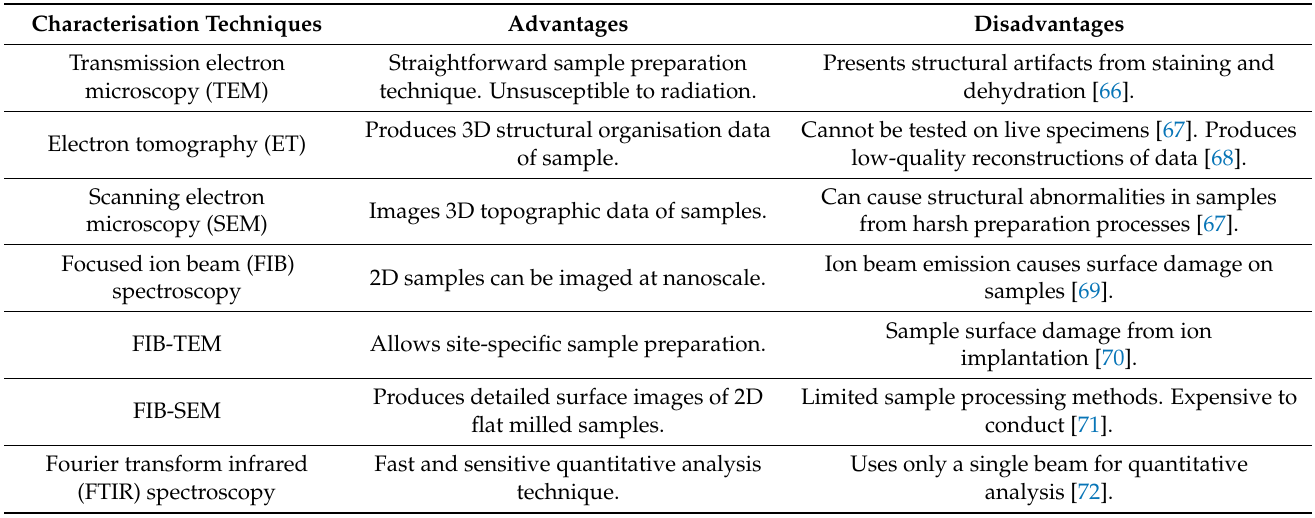
Table 1. The advantages and disadvantages of each characterisation approach technique